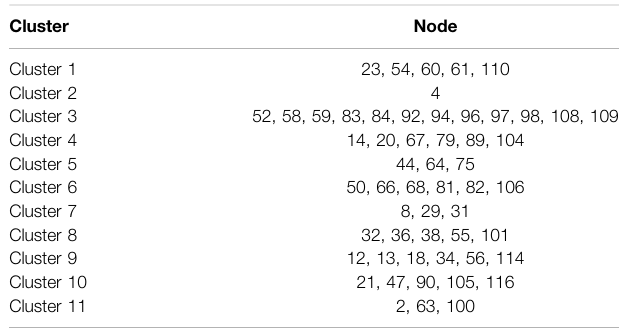
TABLE 3 | Clustering results.